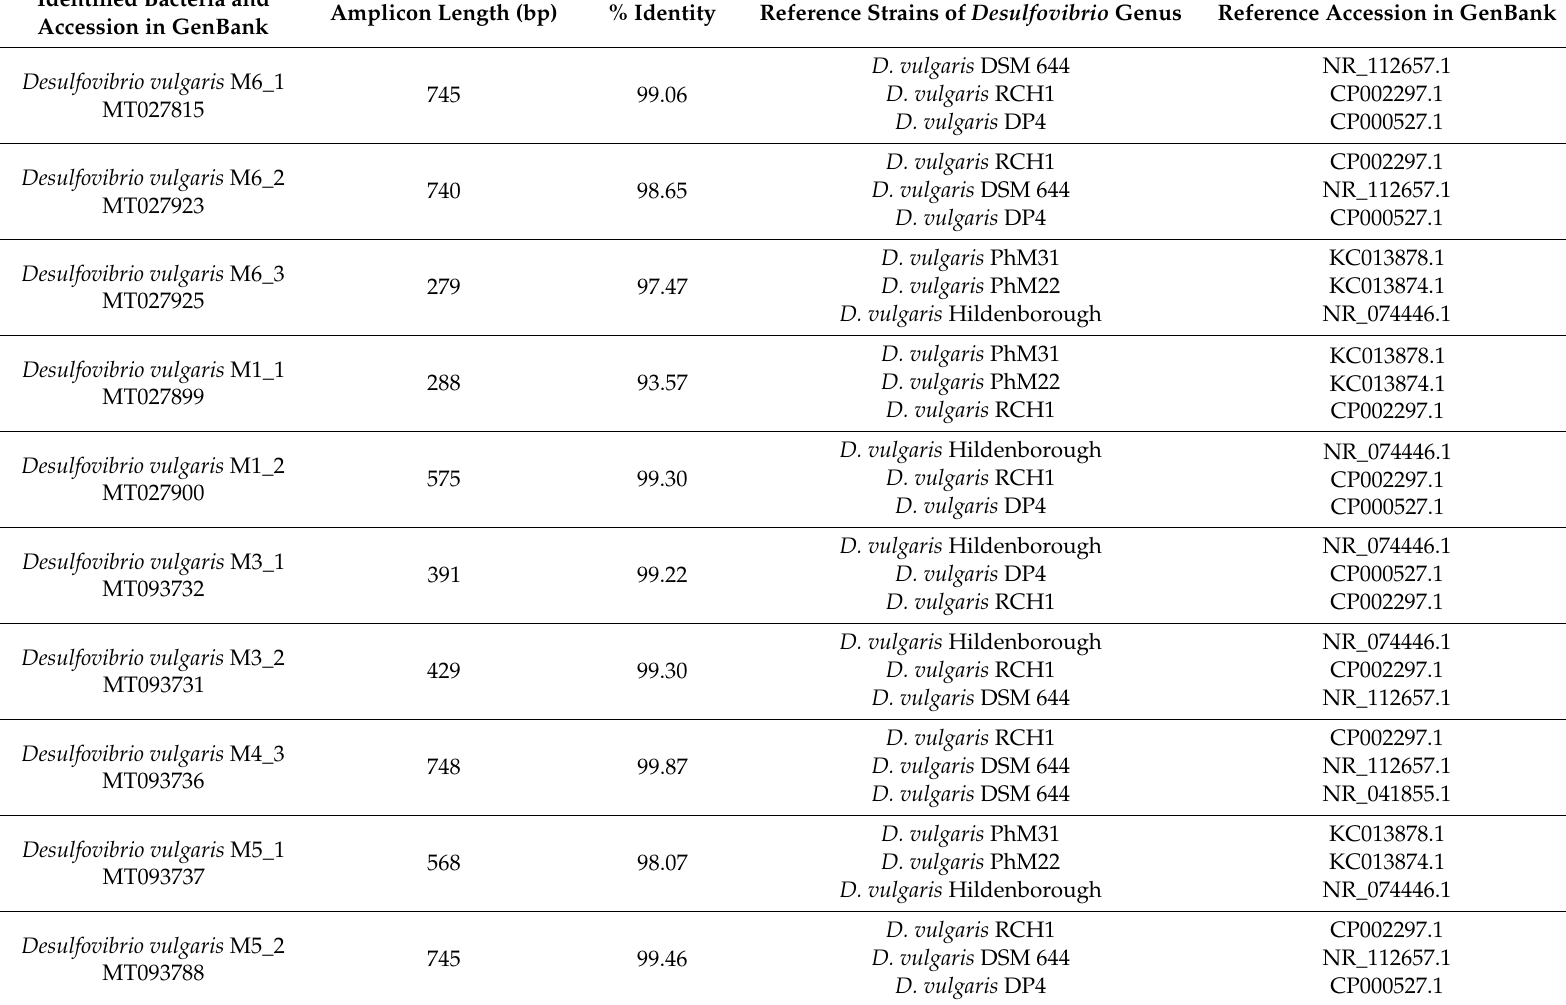
Table 3. Identified species of pure bacterial cultures by sequence analysis of the 16S rRNA